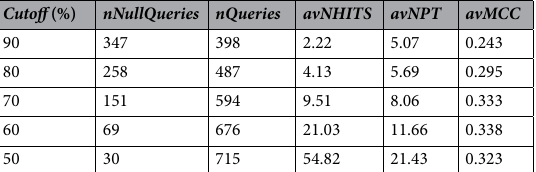
Table 3. Performance of the best method in Table 2 (Tanimoto score on Morgan_hashed_bv_2_2048 fingerprints) using now similarity cutoffs 90%, 80%, 70%, 60% and 50% instead of the top 10 hits. nNullQueries is the number of query molecules for which no hits are found. In contrast, nQueries is the number of query molecules for which at least a hit is found (thus performance is now averaged over nQueries). AvNHITS is the average number of database molecules with similarity scores above the cutoff. The 60% cutoff provides the best performance (avMCC = 0.338 leaving 69 drugs without predicted targets), which is slightly worse than that from using the top 10 most similar this (avMCC = 0.339 leaving no drugs without predicted targets).